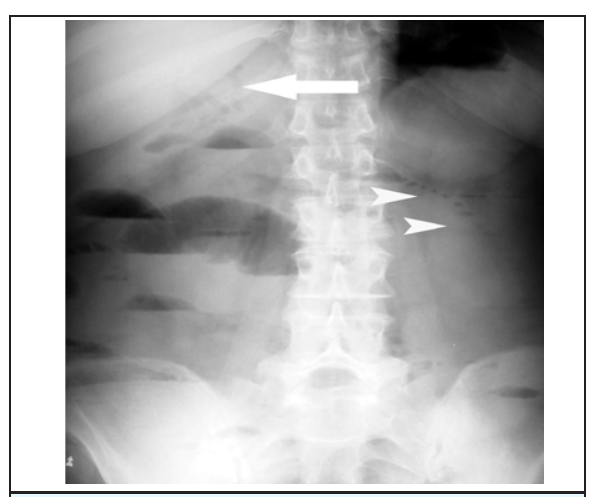
Figure 3. Upright abdominal radiograph shows multiple air–fluid levels. Pneumobilia (arrow) is present, as is string-of pearls sign (arrowheads).